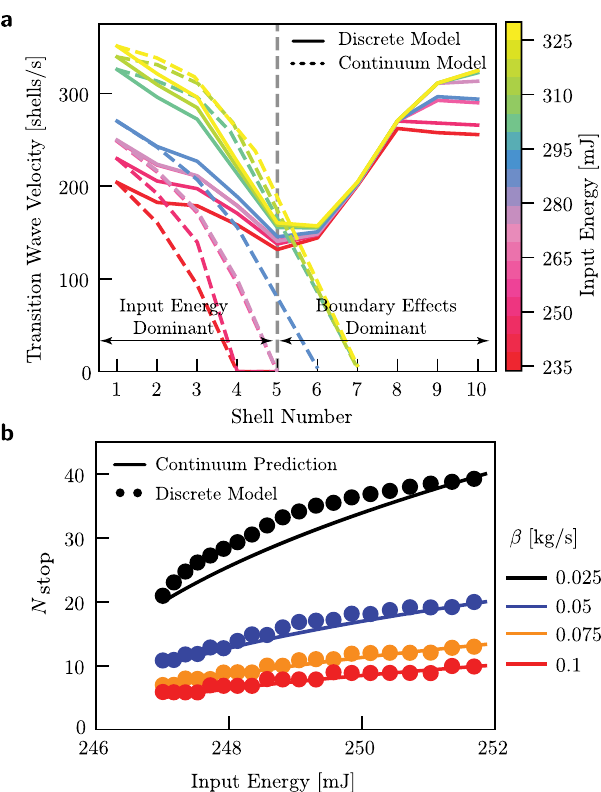
Fig. 5 Effect of dissipation. a Comparison of the continuum and discrete model predictions for the transition wave velocity as a function of the propagation distance for an array of 10 double shells with R = 25.4 mm, H = 15 mm, T = 4 mm and β = 2.5 kg/s. b Theoretical (solid lines, total Eq. (24)) and discrete (markers) model predictions for the number of shells fl ipped before the transition wave stops N stop as a function of the input energy provided to an array of 500 double shells with R = 25.4 mm, H = 15 mm, T = 4 mm, for different levels of viscous dissipation β . Note total that the levels of dissipation investigated in b are much lower than that considered in a